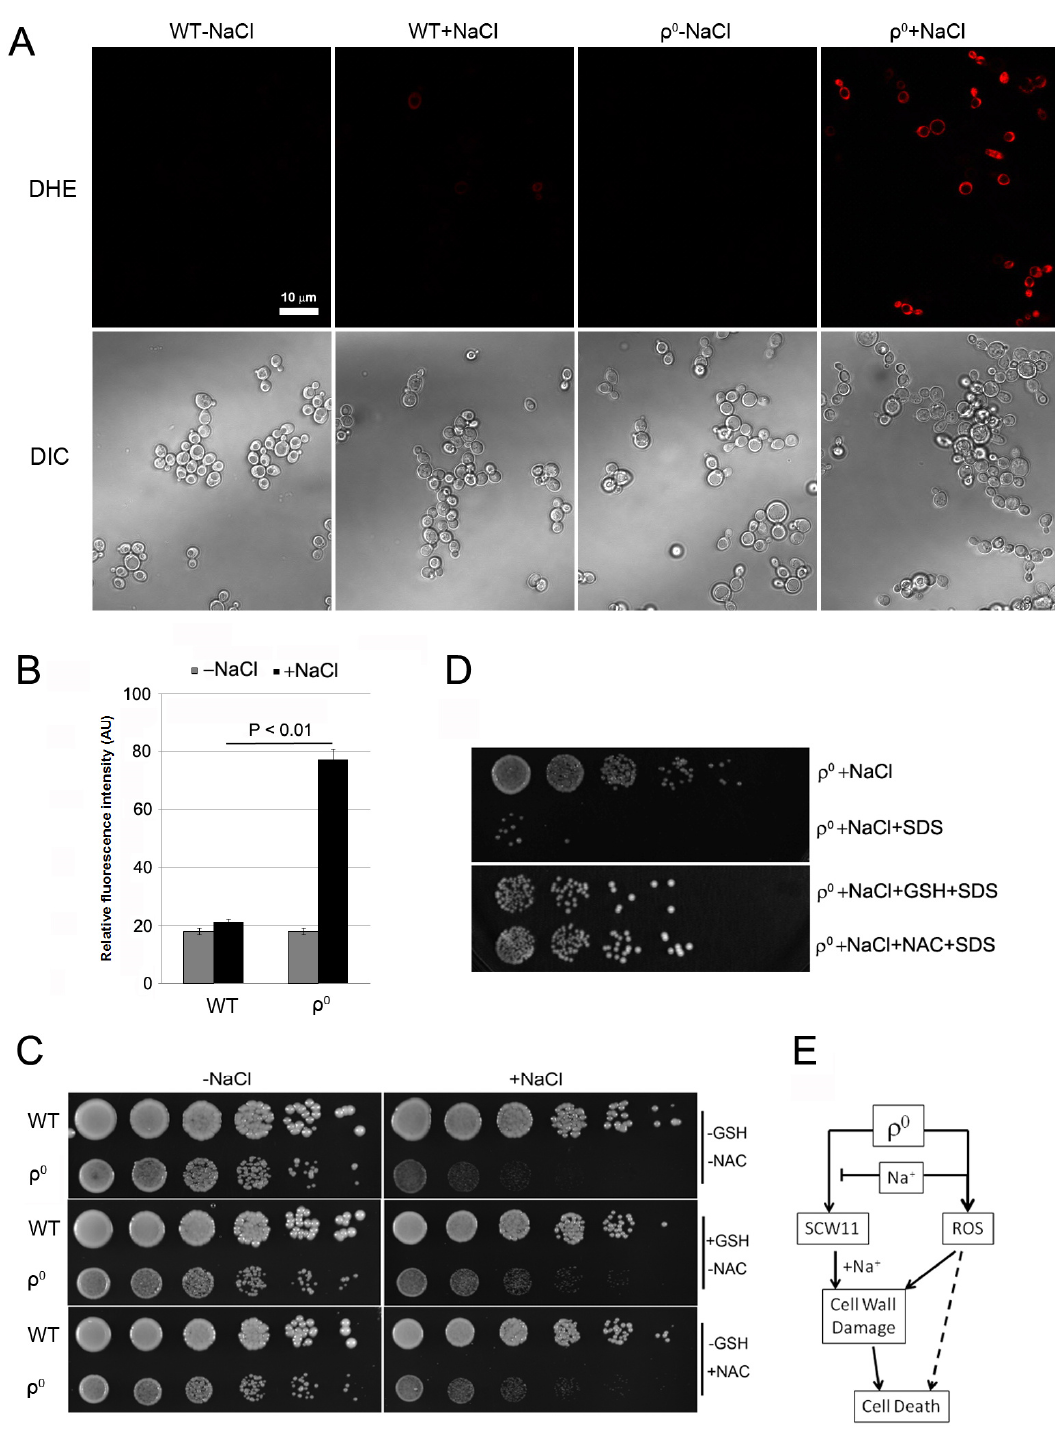
FIGURE 3: (A) and (B) Reactive oxygen species (ROS) production in the WT and ρ 0 cells treated with 0.6 M NaCl for 15 min. (A) After salt stress, ρ 0 cells displayed a higher fluorescence level than WT cells. Staining with 5 µM dihydroethidium (DHE) was used. (B) Quantification of ROS production. Relative fluorescence intensities were measured by the ImageJ software. Values presented are means of three inde- pendent experiments. About 300 cells were measured during each experiment. (C) Antioxidant GSH or NAC slightly decreases the salt sensi- tivity of ρ 0 cells. Log phase cells were spotted directly onto YPD plates containing 0.6 M NaCl and GSH (10 mM) or NAC (20 mM). Cells were cultured at 30 ο C for 2 days. (D) Addition of antioxidant GSH or NAC reduced the sensitivity of ρ 0 cells towards SDS after salt stress. Cells were treated with 0.6 M NaCl in presence of GSH (10 mM) or NAC (20 mM) for 1 hr. Cells were washed, treated with SDS for 0.5 hr and spotted on YPD plates. Cells were then cultured at 30 ο C for 2 days. (E) Diagram showing the possible involvement of SCW11 and ROS in salt stress-induced cell wall damage and cell death of ρ 0